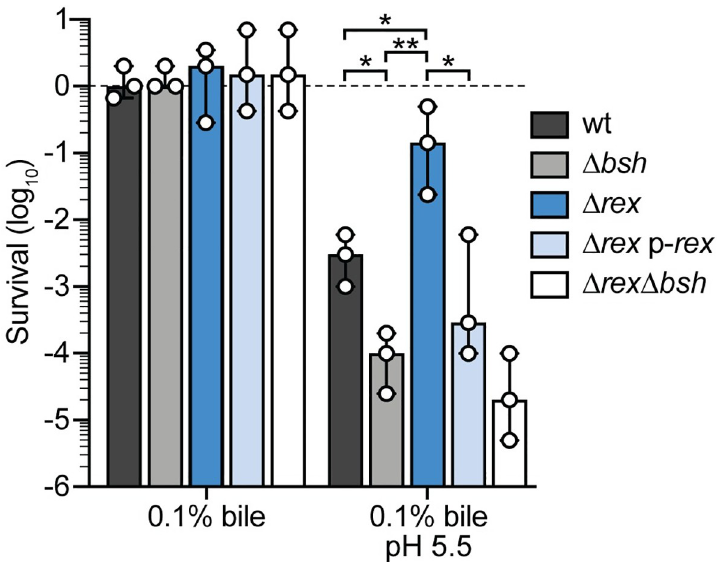
Fig 2. Alleviation of Rex repression promotes bacterial survival in acidified bile. Survival of wt (black), Δ bsh (grey), Δ rex (blue), Δ rex p- rex (light blue) and Δ rex Δ bsh (white) normalized to the initial inoculum (dashed line = 1) and expressed as log-transformed CFU per mL of culture. Strains were evaluated for survival 24 hours post-inoculation in BHI supplemented with bile or acidified BHI supplemented with bile under aerobic conditions. Data are the means and ranges of three independent experiments. p values were calculated using a heteroscedastic Student’s t test. � p < 0.05; �� p < 0.01; n.s. p > 0.05. No significant difference was found between the Δ bsh and Δ rex Δ bsh